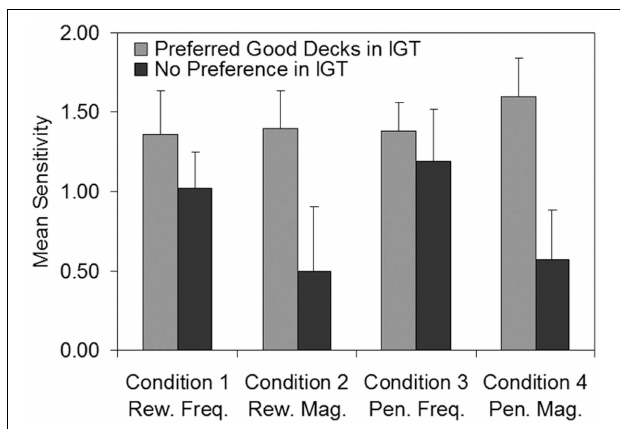
FIGURE 7 | Mean sensitivity estimates in the Auckland Card Task for participants who preferred the good decks ( n = 19 ) in the Iowa Gambling Task vs. participants who developed no strong preference ( n = 9 ). Error bars show standard error of the mean. Freq, Frequency; IGT, Iowa Gambling Task; Mag, Magnitude; Pen, Penalty; Rew,